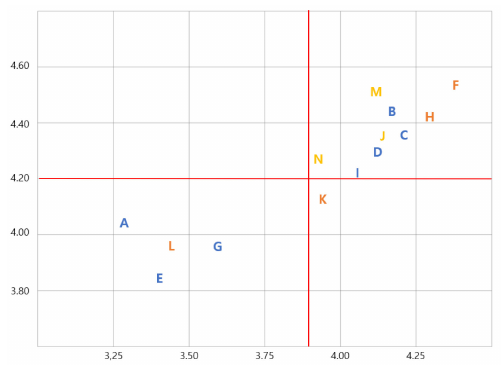
Figure 3. IPA (all age